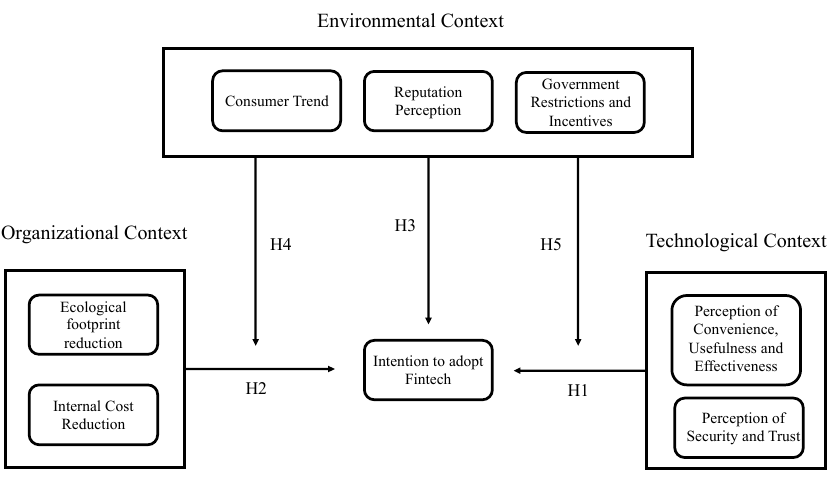
Figure 1. Proposed conceptual model.